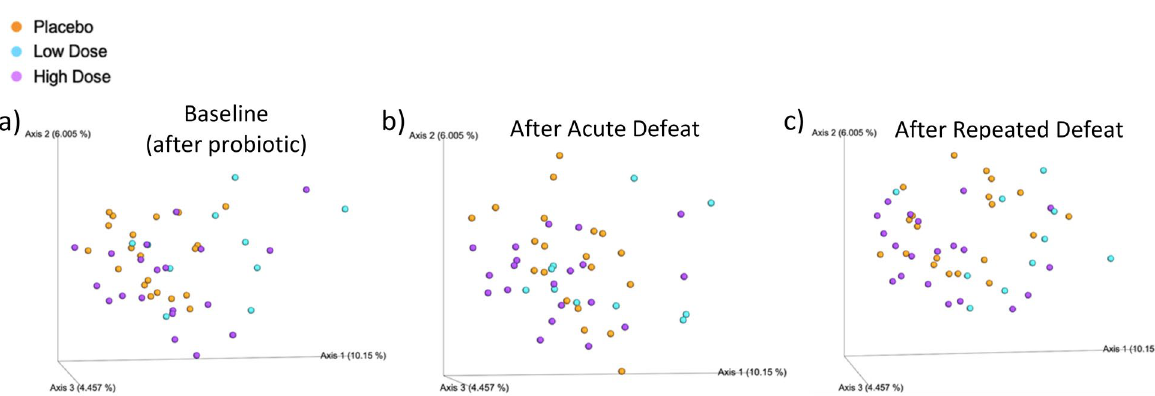
Figure 3. Probiotic intervention alters the gut microbial composition before and after social stress. Principle coordinate analysis (PCoA) of the unweighted UniFrac distance at baseline ( a ), after acute social stress ( b ), and after repeated social stress ( c ). Although not immediately obvious based on the PCoA plots, the unweighted UniFrac distance revealed that at “baseline” (after probiotic treatment but before any behavioral manipulations) the microbial composition of each treatment group differed from one another ( a ) and that, after acute social stress, the microbial composition of hamsters administered the low dose of the probiotic ( n = 10) (orange dots) differed from that of hamsters administered the high dose ( n = 20) (red dots) ( b ). Following repeated social stress, unweighted UniFrac revealed that the microbial composition of hamsters treated with a low dose of the probiotic ( n = 10) (orange dots) was different than that of both the placebo-treated hamsters ( n = 20) (blue dots) and the hamsters treated with a high dose of the probiotic ( n = 20) (red dots) ( c ). P values were determined using PERMANOVA analysis and denoted as significant at p < 0.05 ( a – c